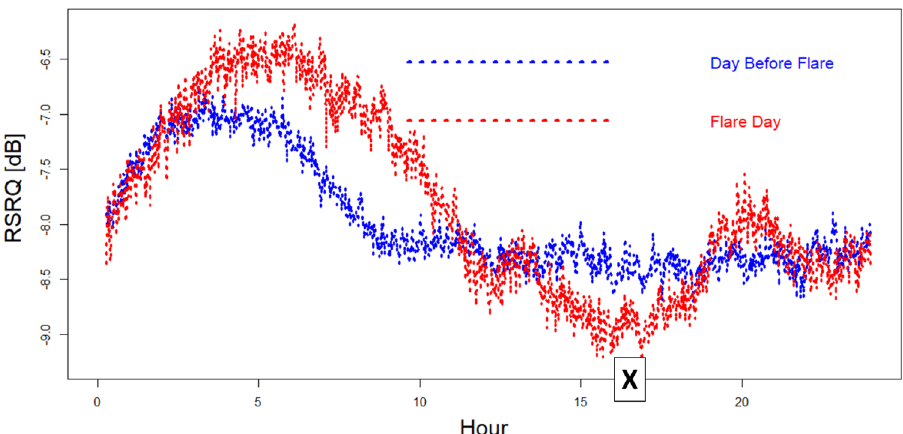
Figure 15. Comparison of RSRQ (received signal reference quality) measured by mobile terminals during July 2nd (blue line) and July 3rd (red line). A quality drop is visible for the hours close to the Sun flare. “X” indicates the flare peak in X-ray emission (local Italian time, UT +